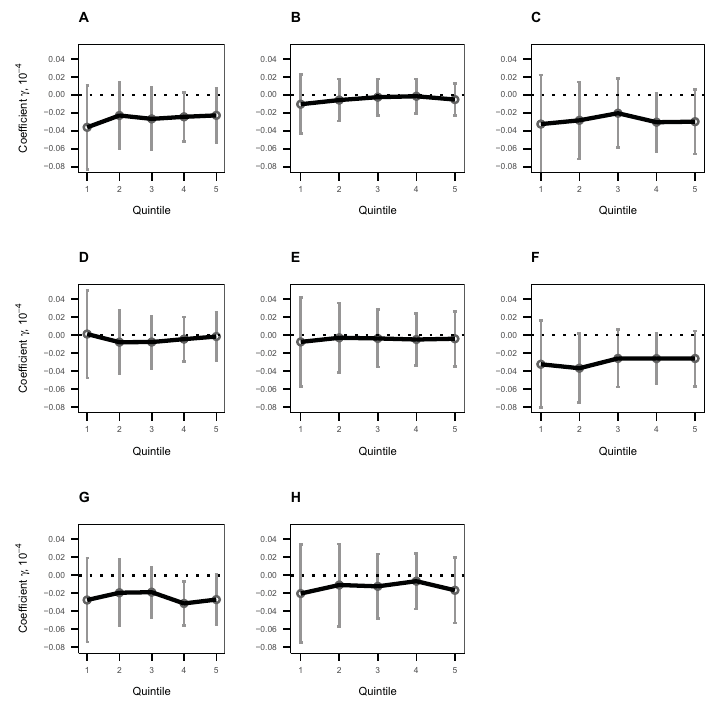
Fig 6. The estimated coefficients of seven-day PM 10 concentration on non-respiratory patients by quintile. The estimated coefficients (multiplied by 10 4 ) of the seven-day concentration on the likelihood of non-respiratory disease, listed in S5 Table, are presented with 95% error bars for each quintile: ( A ) Infectious and parasitic disease; ( B ) Nutritional and metabolic diseases; ( C ) Diseases of the eye and adnexa; ( D ) Diseases of the circulatory system; ( E ) Diseases of the digestive system; ( F ) Diseases of the skin and subcutaneous tissue; ( G ) Diseases of the musculoskeletal system and connective tissue; and ( H ) Injury, poisoning, and certain consequences of external causes.